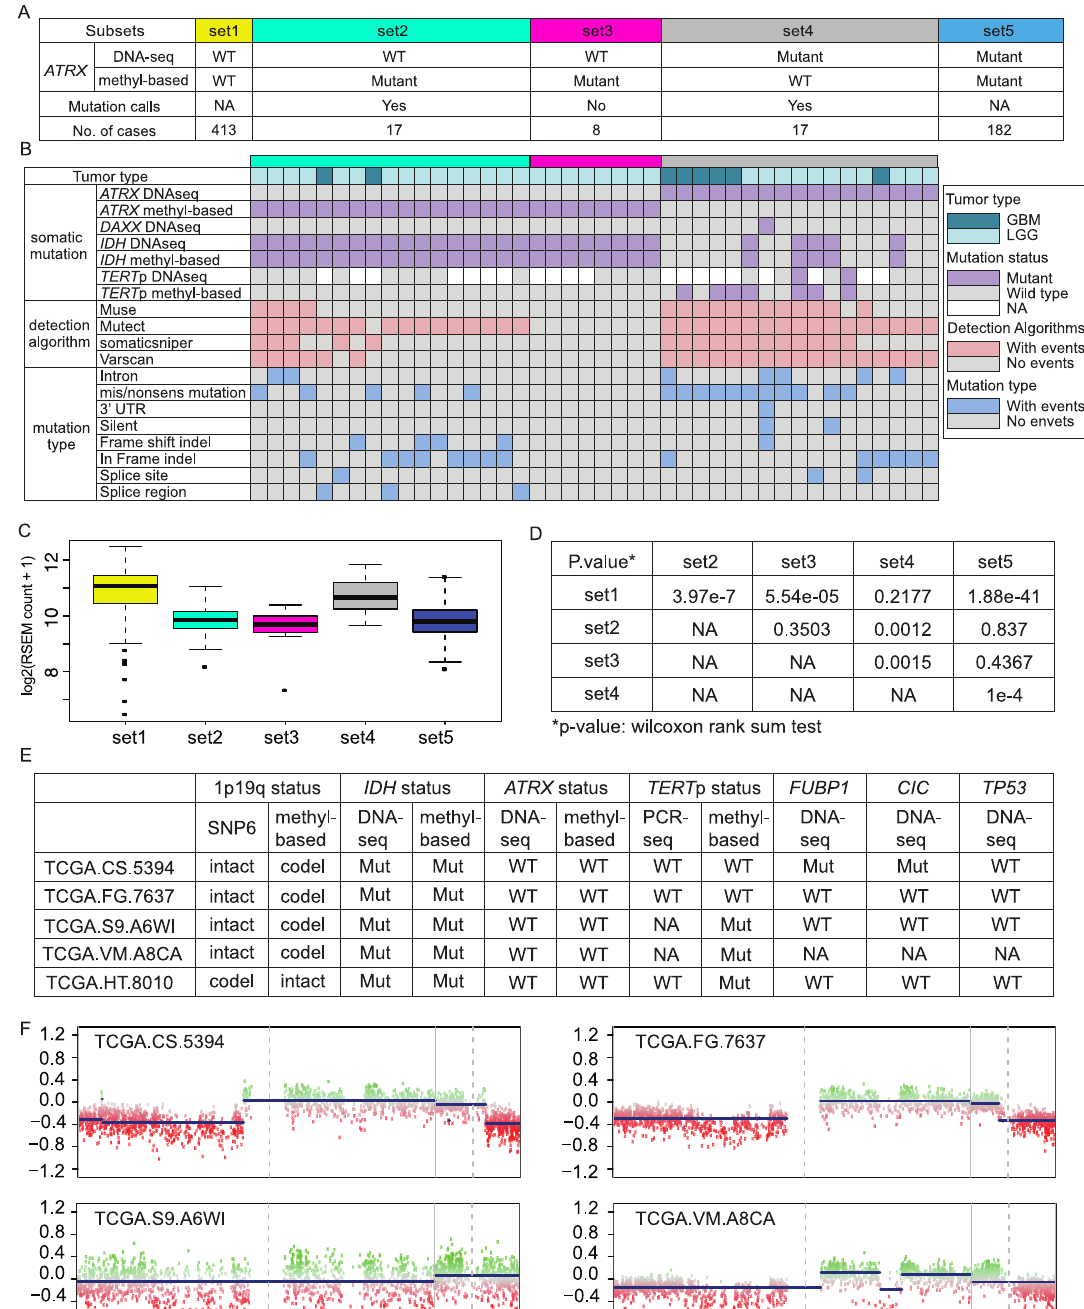
TCGA-19-5951 in Grp7 showed signi fi cant chr10 loss and chr19p and chr20 ampli fi cation (Fig. 4E). Fifth row: A IDH, HG in Grp8 are expected to be IDH mutant by Unsupervised CNS Classi fi cation but, in fact, were wild type by sequencing. Sixth row: Two samples from adult patients (TCGA-06-5858 and TCGA-06-6698) were classi fi ed as IHG (infantile hemispheric glioma) by Unsupervised